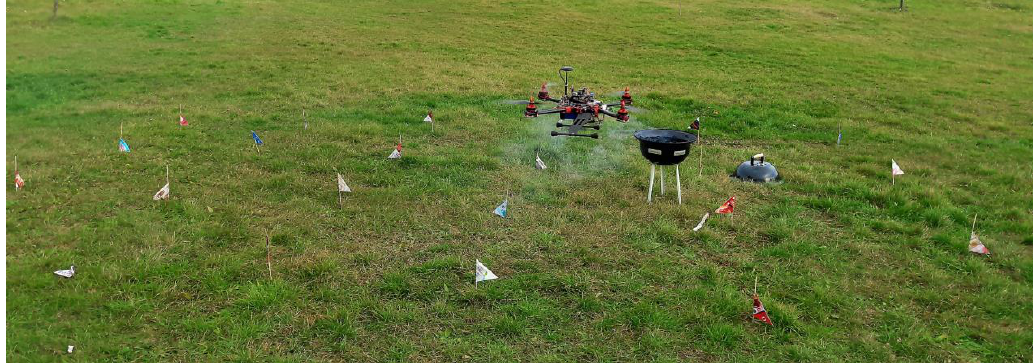
Figure 8. Sni ff er quadcopter field